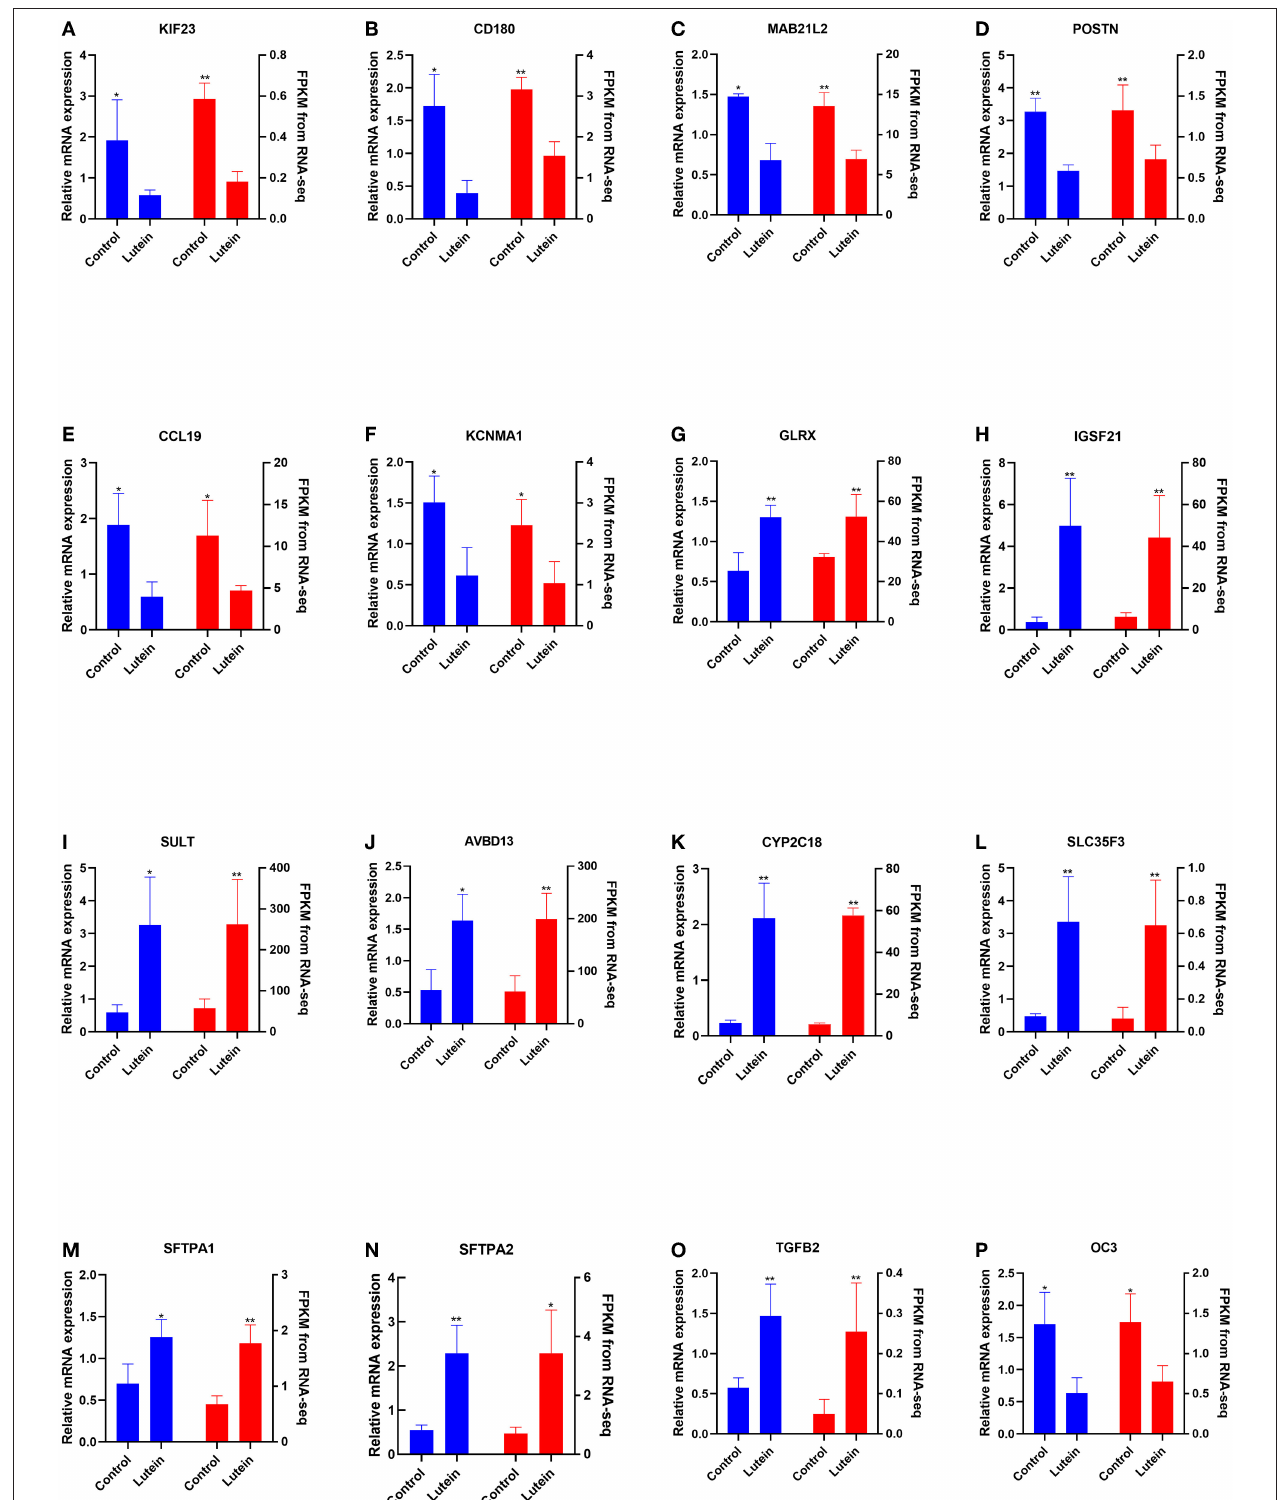
FIGURE 4 | Comparison of the gene expression of RNA-seq with qPCR. The left and right Y axes represent the expression levels verified by qPCR and gene expression using FPKM units by RNA-seq, respectively. The blue column indicates qPCR; the red column indicates the FPKM value. The data represent the relative mRNA expression and FPKM of (A) KIF23 , (B) CD180 , (C) MAB21L2 , (D) POSTN , (E) CCL19 , (F) KCNMA , (G) GLRX , (H) IGSF21 , (I) SULT , (J) AvBD13 , (K) CYP2C18 , (L) SLC35F3 , (M) SFTPA1 , (N) SFTPA2 , (O) TGFB2 , and (P) OC3